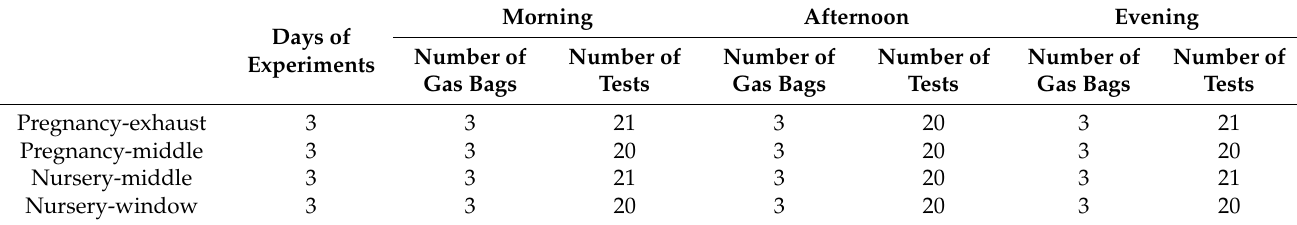
Table 2. Gas sample information and number of electronic nose tests for pig house.